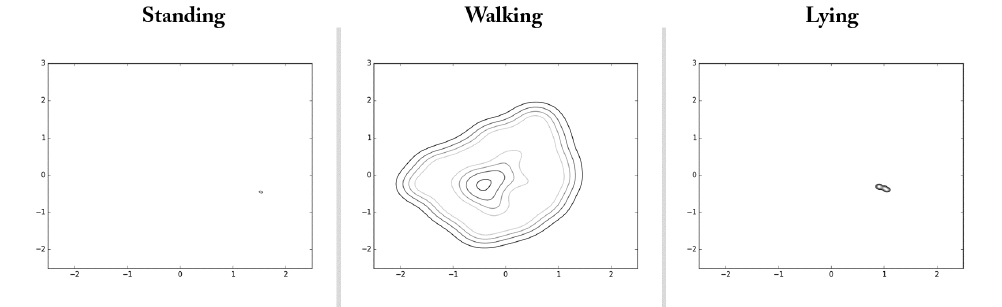
Figure 9. Results for intrinsic characteristics of walking, standing, and